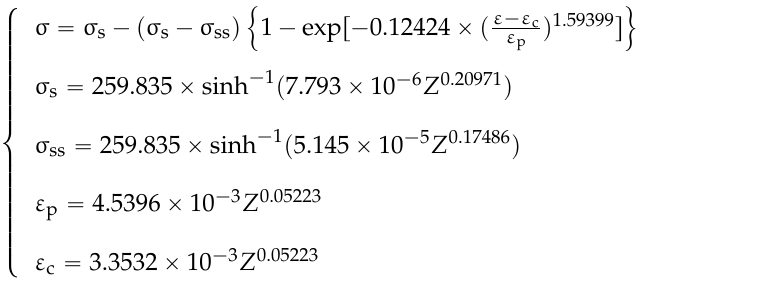
X  vs. . Figure 16. The plot of ln r´ ln p 1 ´ X ε ´ ε c q{ ε p q d qs vs. ln pp d